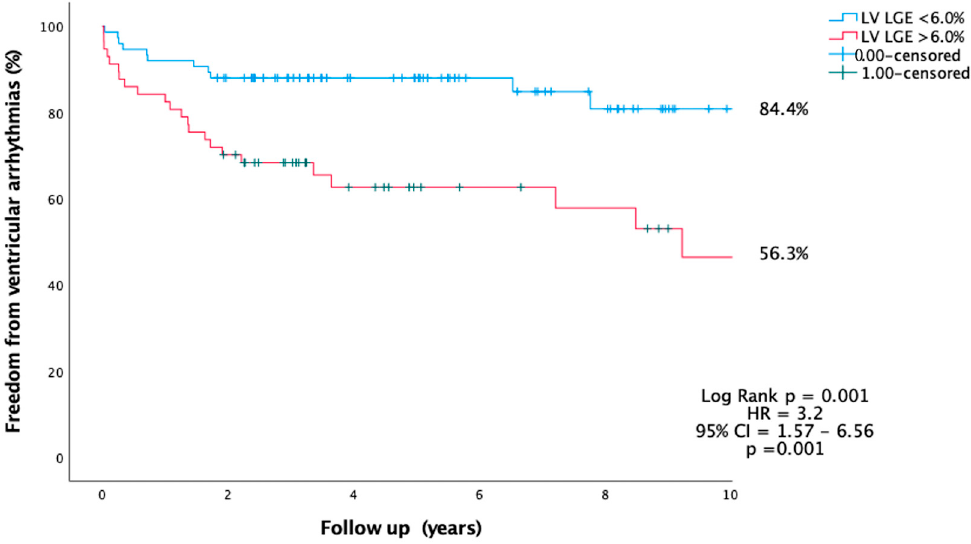
Figure 9. Kaplan Meier analysis of LV LGE and freedom from ventricular arrhythmia over a follow-up of 10 years .